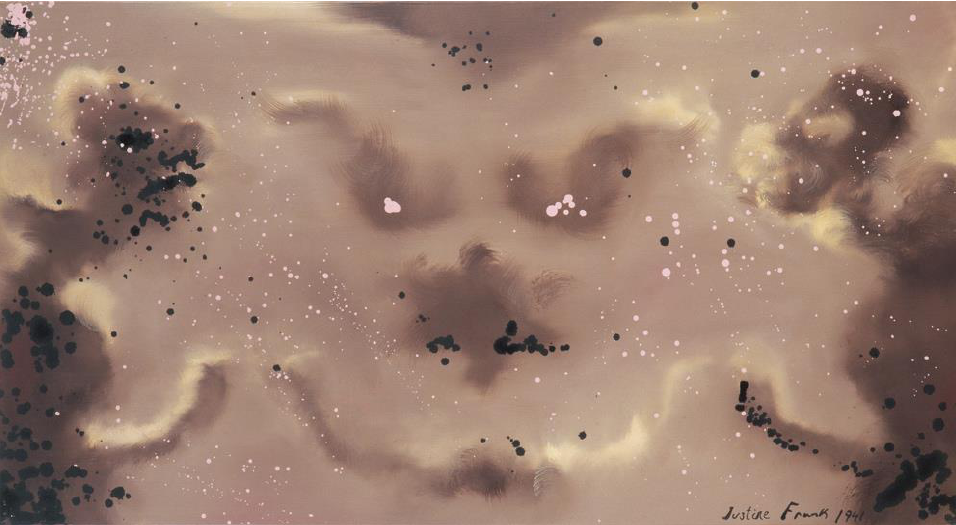
Figure 26. Justine Frank, Heaven Manure , 1941, oil on canvas, 60 × 110 cm. Courtesy of the artist.